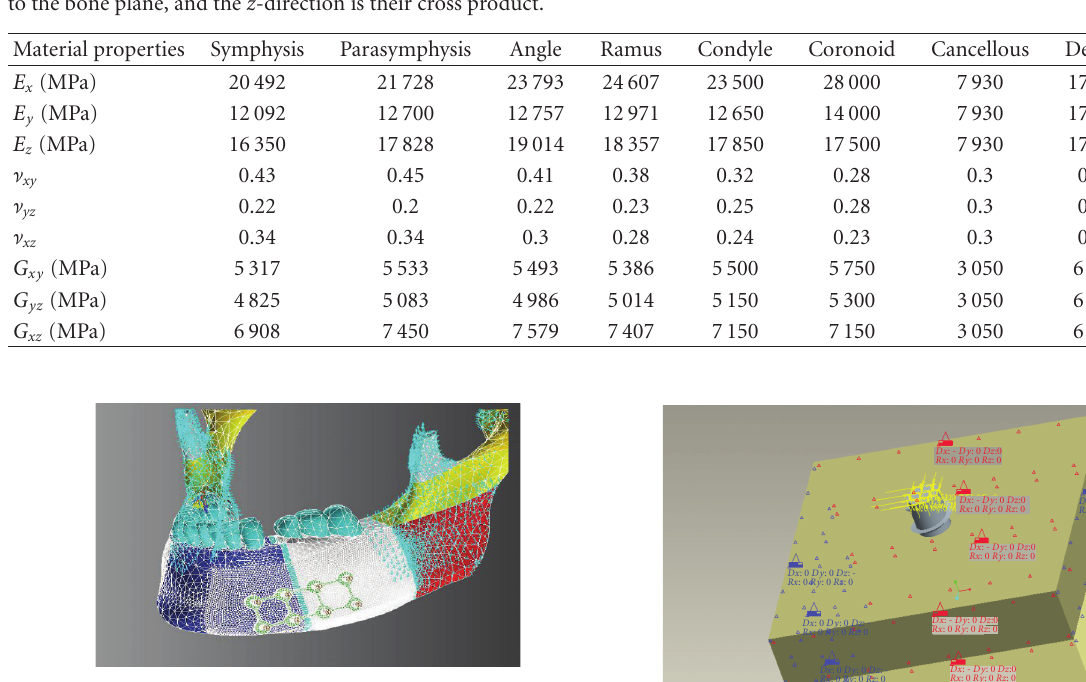
Figure 3: Meshed mandibular model showing a parasymphyseal fracture, fixation plates and screws, and di ff erent material regions for orthotropic material properties.